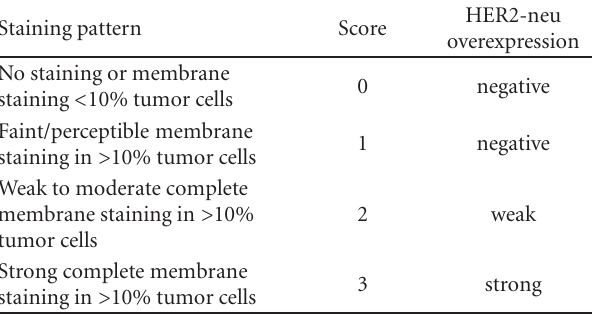
Table 1: HER2-neu scoring.